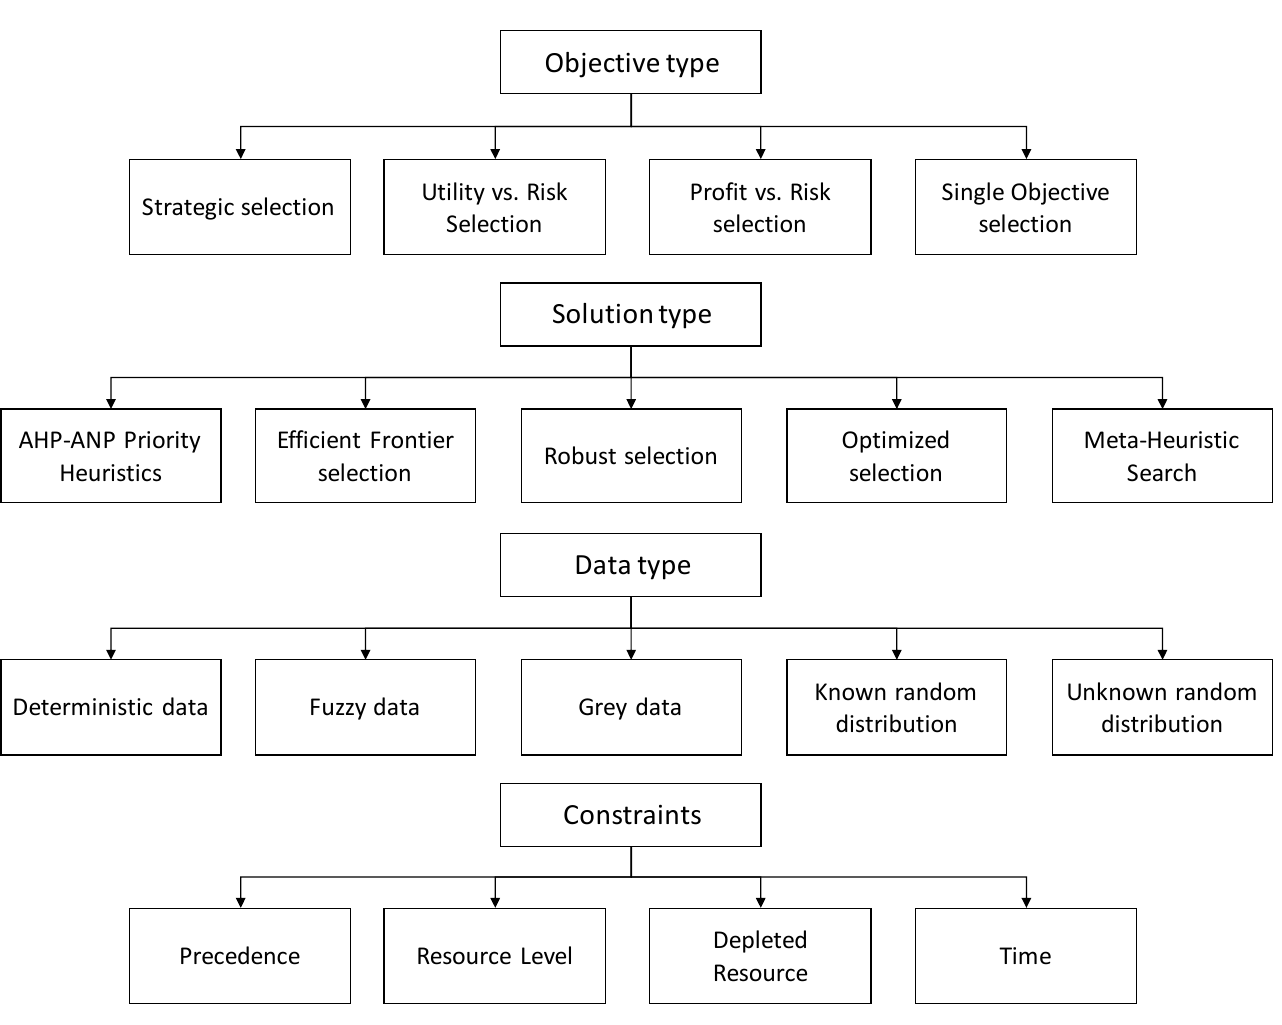
Figure 1. Project portfolio selection classification scheme.